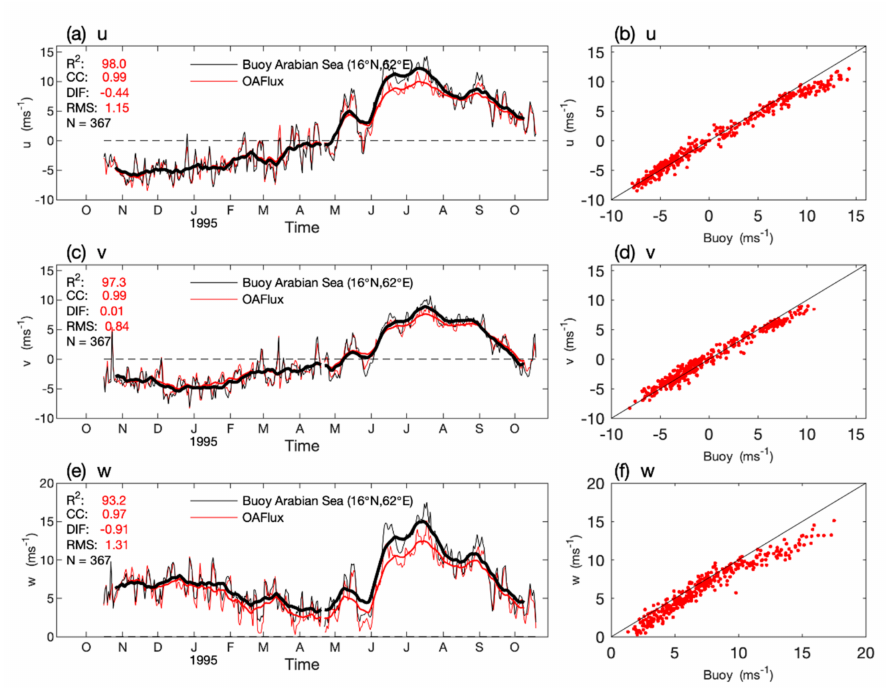
Figure 4. Left column: time series plots of daily buoy winds (thin black) versus OAFlux-HR winds (thin red). Right column: scatter plots of collocated pairs at the Arabian Sea buoy location 16 ◦ N, 62 ◦ E ( a , b ) zonal wind component, ( c , d ) meridional wind component, ( e , f ) wind speed. Thick smoother lines in ( a , c , e ) denote a 21-day running mean with black for buoy and red for OAFlux-HR.